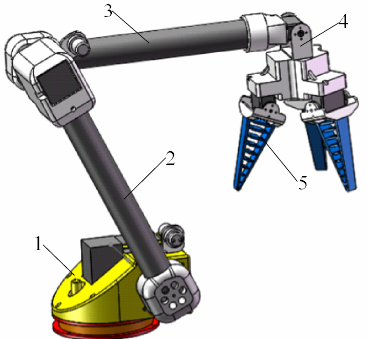
Figure 9. Three-dimensional view of the manipulator. 1. Waist joint; 2. Big arm; 3. Small arm; 4. Wrist joint; 5. End effector.